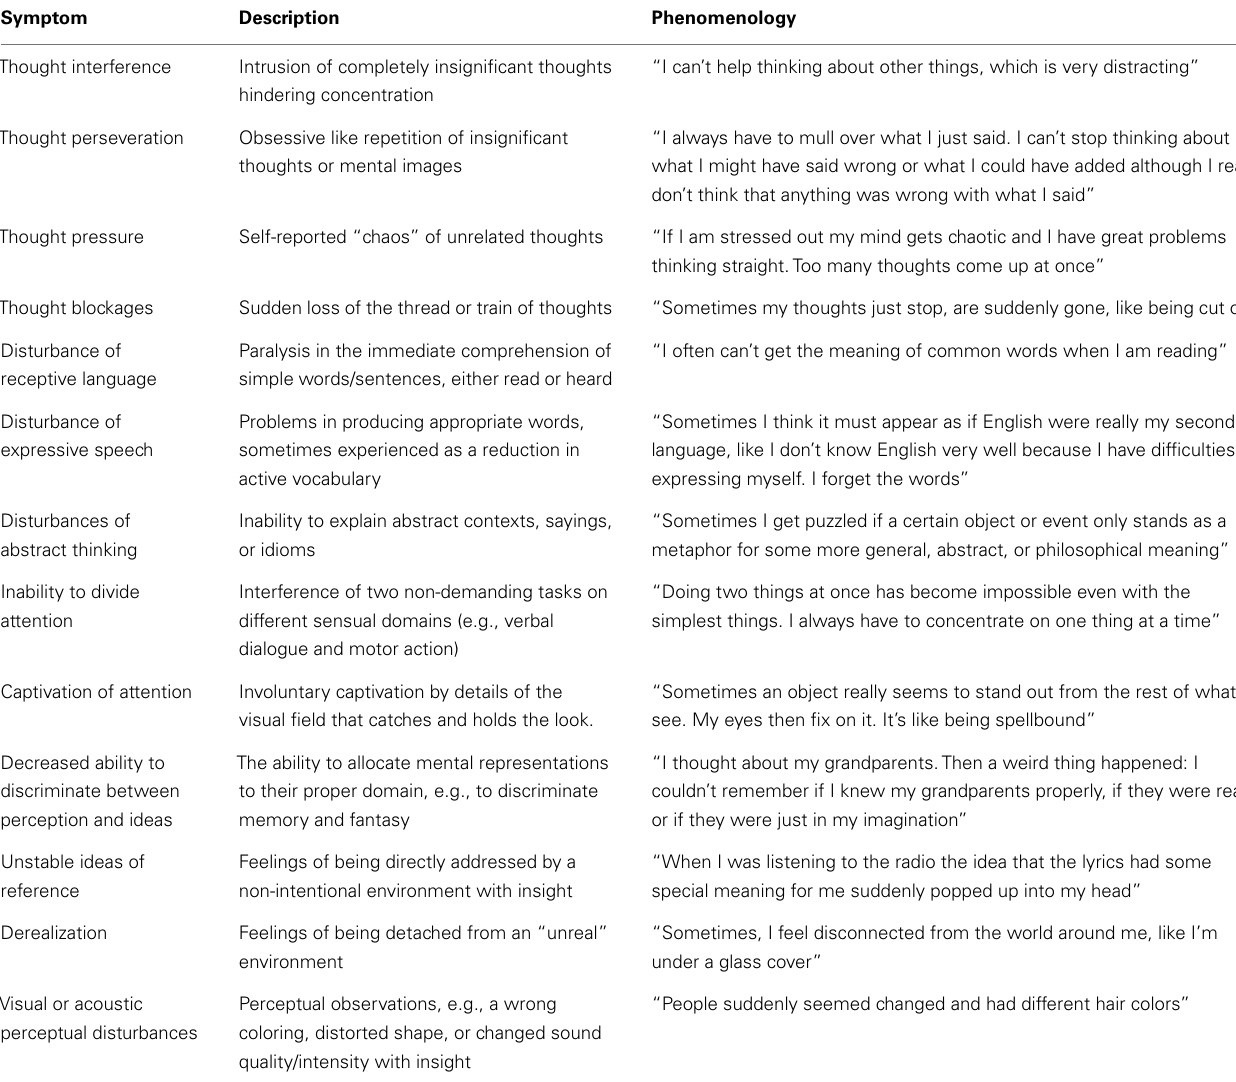
Table 1 | Predictive basic